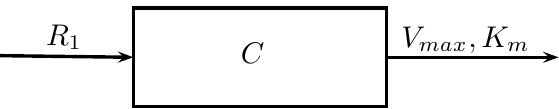
Figure 3. Schematic representation of IV infusion with Michaelis-Menten